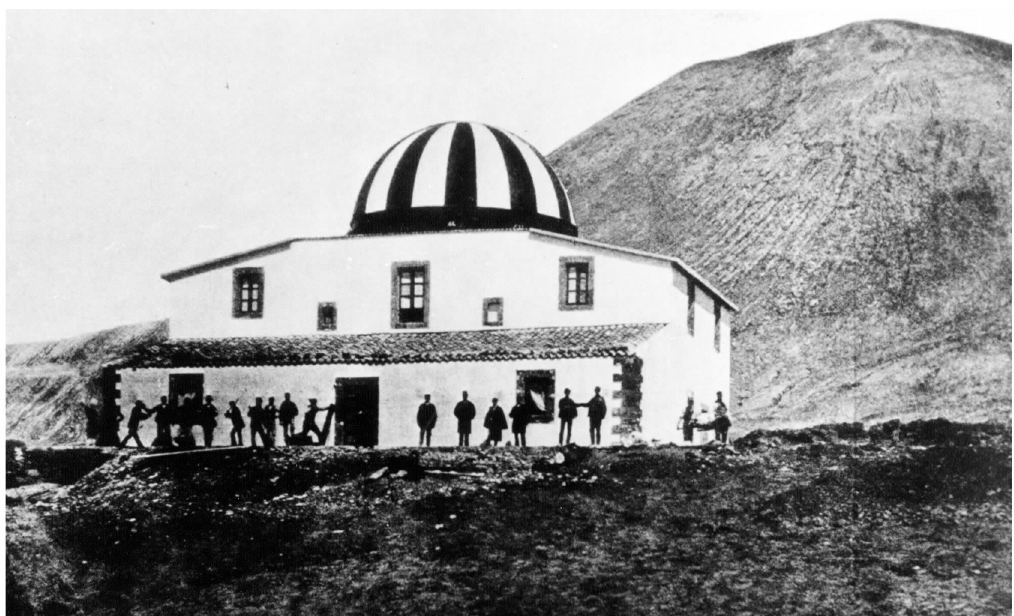
Fig. 3. The Bellini Observatory on the Mount